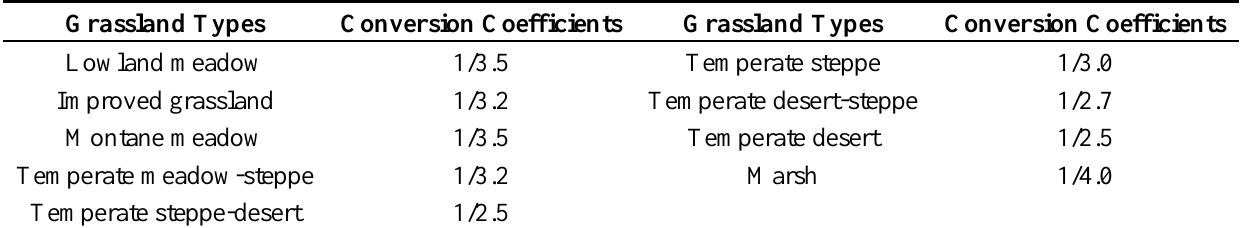
Table 1. Conversion coefficients of grassland